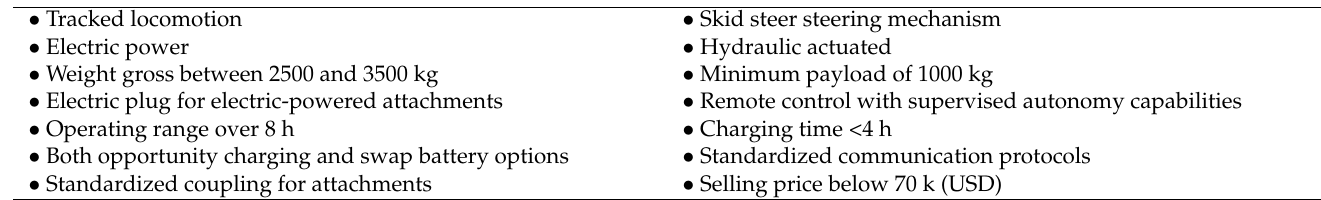
Table 2. Characteristics identified through the use of the metrics for the development of a